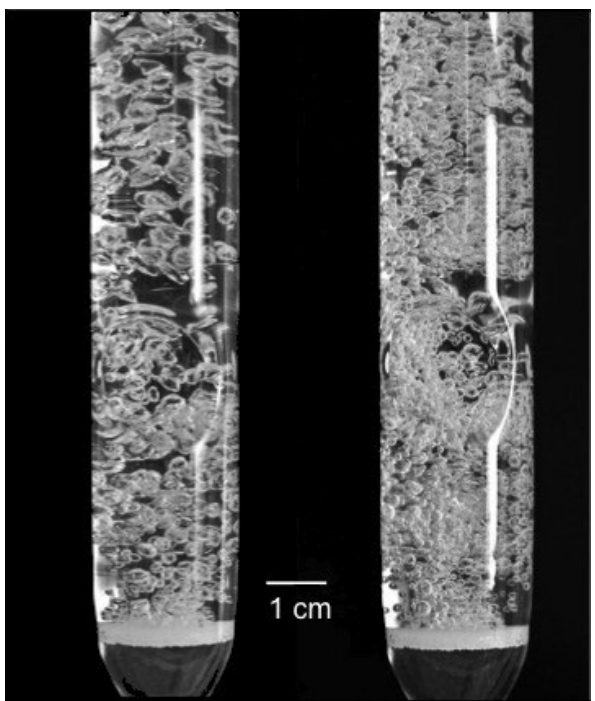
Figure 6. The gas bubbles diffuse through water (left) and through a 0.3 M NaCl solution. In the salt solution the bubbles coalescence is remarkably reduced. Courtesy of Vincent S. J.